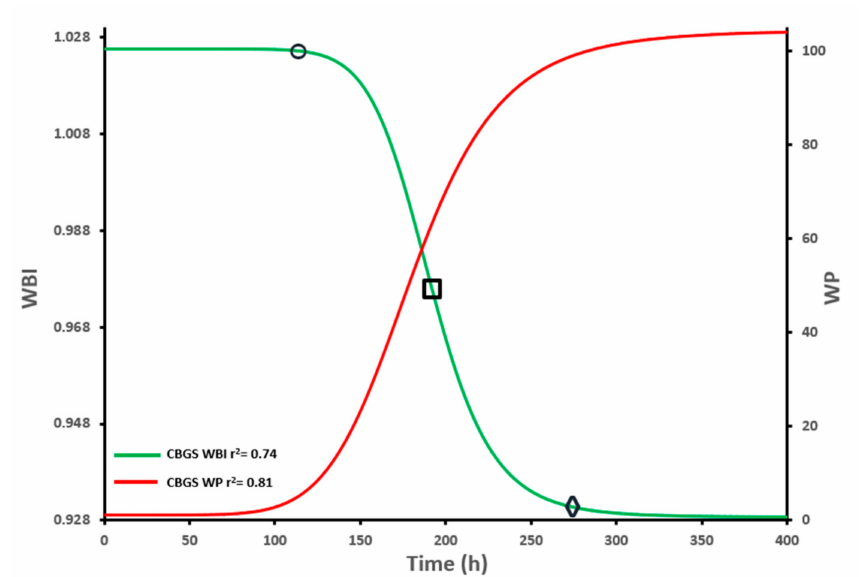
Figure 1. Four-parameter nonlinear logistic regression analysis of spectral reflectance and visible wilt percentage (WP) gathered over time from creeping bentgrass established in USGA 90:10 sand (CBGS) subjected to greenhouse conditions in Blacksburg, VA. The water band index (WBI = R 900 /R 970 ) was pooled over six dry-down cycles to model the response to withheld soil moisture over time (h) from initiation of each cycle. The , (cid:3) , and ♦ indicate the upper asymptote, inflection point (IP), and (cid:35) lower asymptote,